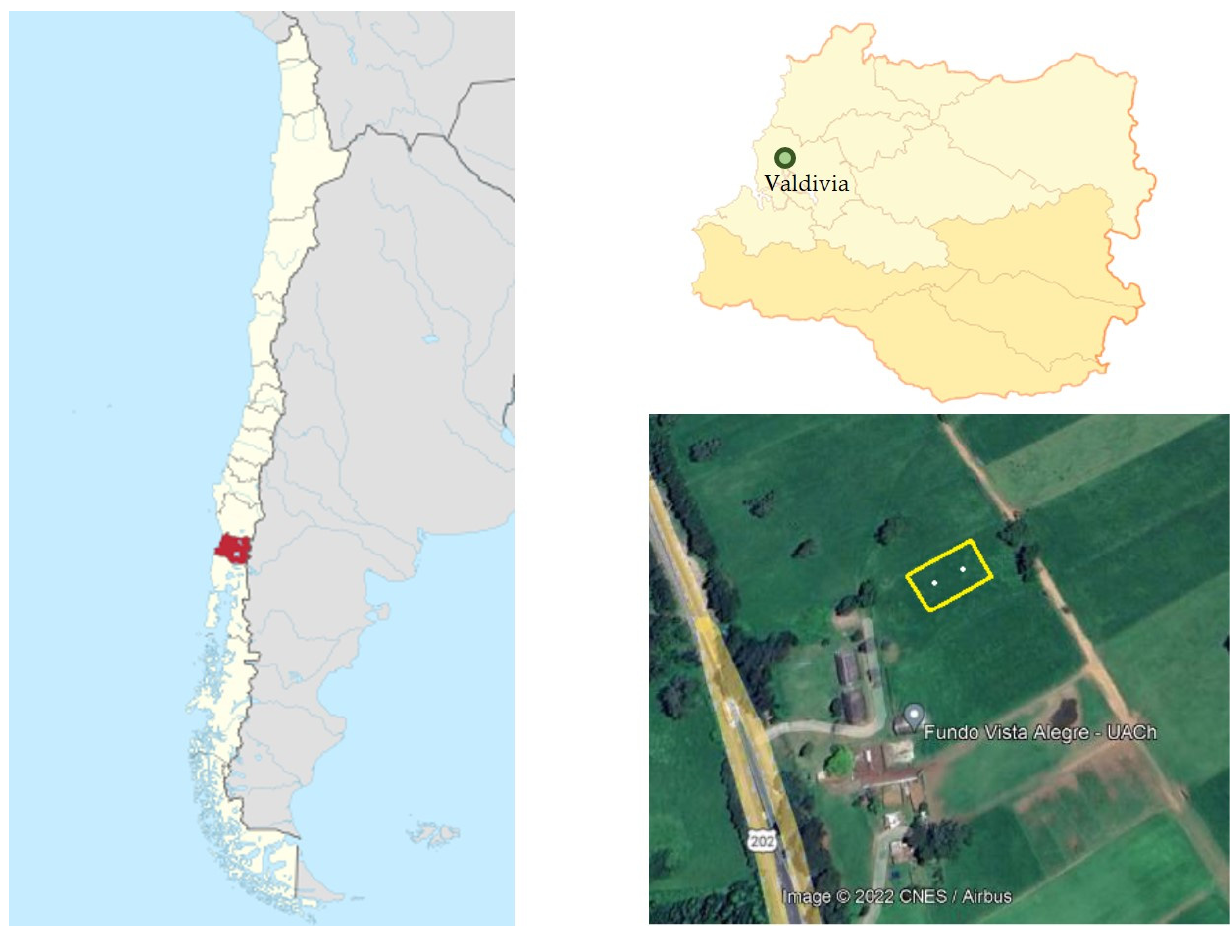
Figure 1. Map of Chile. The red area represents Región de Los Ríos. Green circle represents the experimental location. Yellow rectangle and white points represent the experimental area experimental repetitions, respectively.